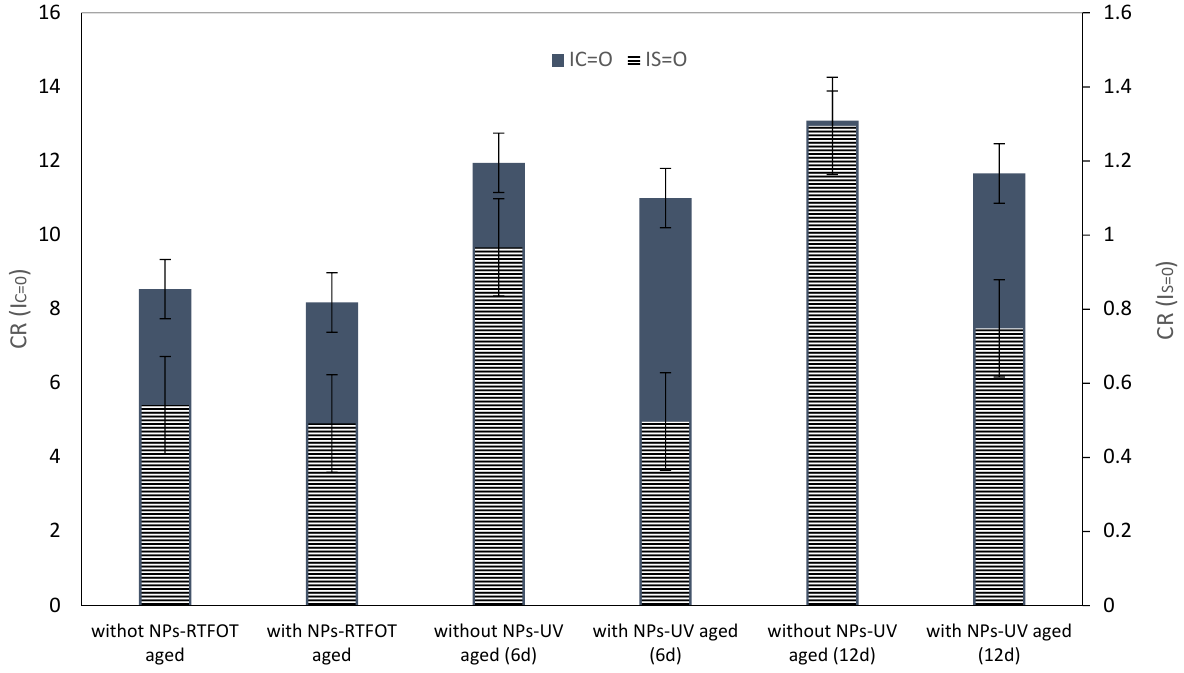
Figure 5. Structural index of bitumen before and after laboratory aging.